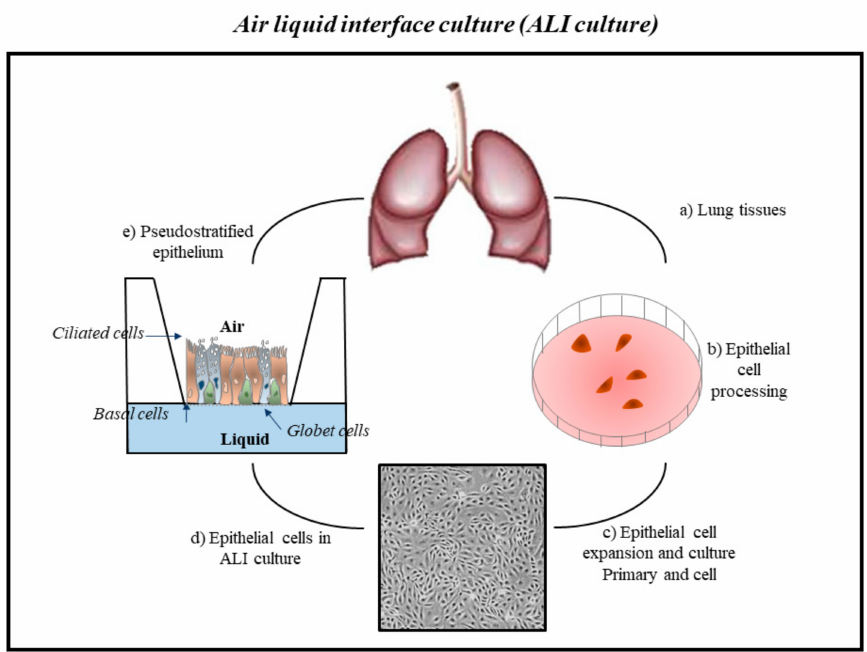
Figure 2. Three-dimensional (3D) ALI cultures of epithelial cells (primary and cell line) to study the effects of environmental contaminants in airway disease. Steps to obtain primary epithelial cells from human tissue: ( a ) Collection of bronchial biopsies or surgical specimens; ( b ) epithelial cell processing: tissue was dissociated, resuspended in bronchial epithelial growth medium; ( c ) cell expansion and culture of epithelial cells; ( d ) the cells are seeded onto the microporous membrane pre-coated with collagen in submerged conditions until confluence and culture in ALI; ( e ) reaching the confluence, the cells begin to lift at the air–liquid interface starting the differentiation fed by the culture medium in the basolateral side. Hence, the epithelial cells differentiate in the pseudostratified phenotype and build a tissue such as the epithelium of the